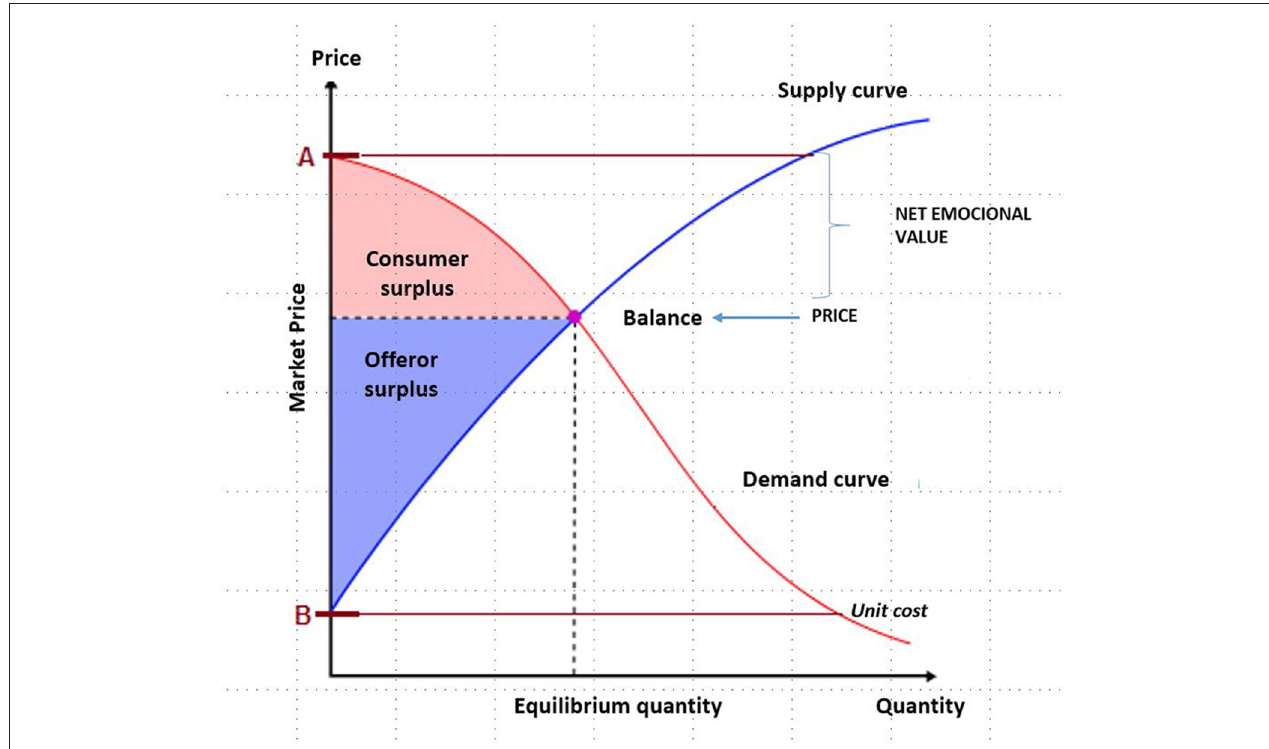
FIGURE 2 | Emotional value breakeven point. Source: own compilation based on Samuelson and Nordhaus (1989).